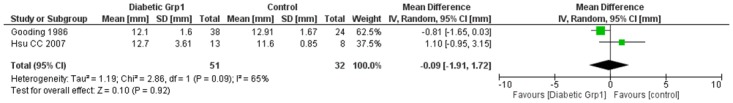
Meta-analysis and forest plot for sub-metatarsal head 4 unloaded total soft tissue depth, non-diabetic and diabetic group 1.